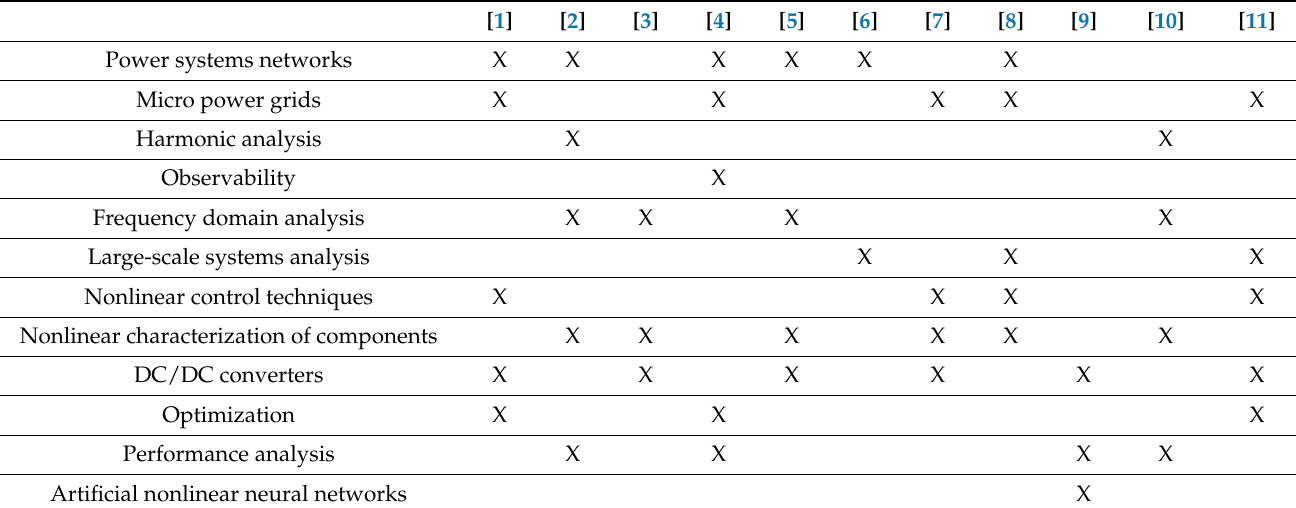
Table 1. Correlation matrix of the selected